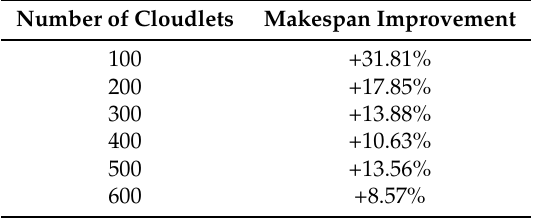
Table 8. Improvements over the original MBO in simulations with artificial data set.